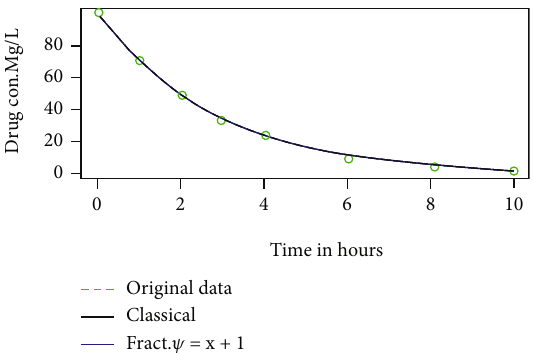
Figure 5: Original, classical, and fract. ψ ð x Þ = x + 1